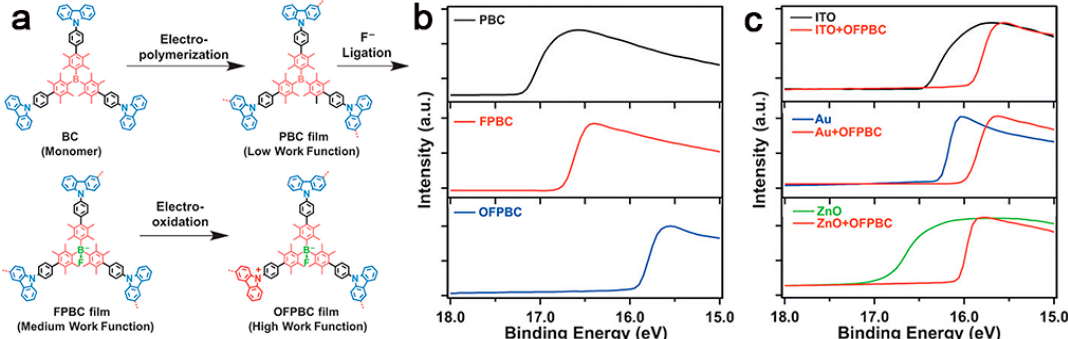
Figure 4. A synthesis route of ionic OFPBC films ( a ); secondary electron cut-off obtained by ultraviolet photoelectron spectroscopy for PBC , FPBC , and OFPBC films ( b ); ITO, Au and ZnO samples with and without 20 nm-thick OFPBC films. The shift represents the change of the work function ( c ). Reprinted with permission from [72]. Copyright 2016, Wiley-VCH.